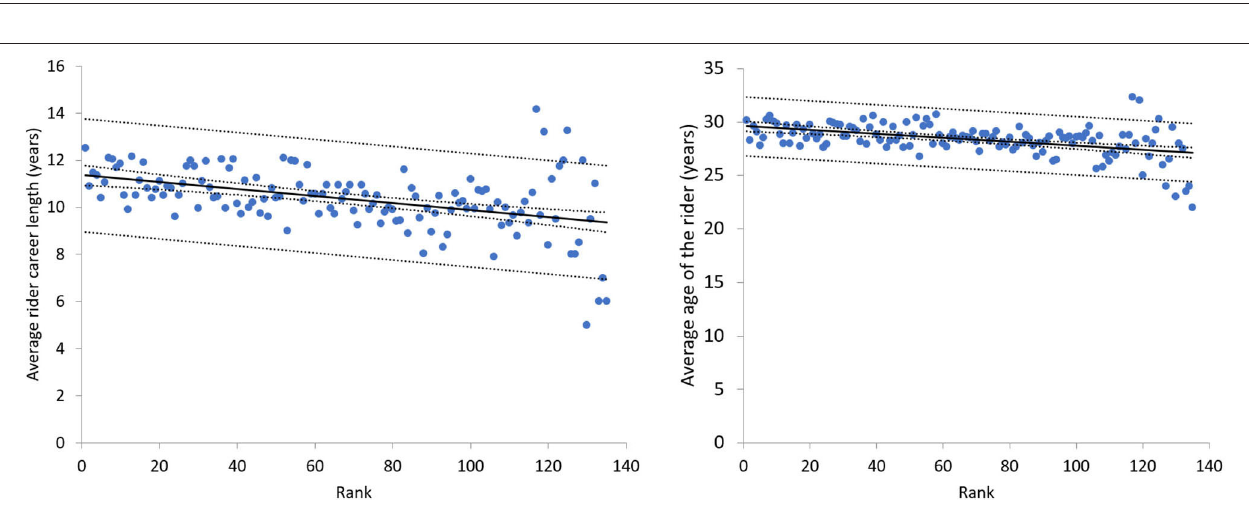
FIGURE 4 | Results from Alejandro Valverde and Philipe Gilbert over the years on Liège-Bastogne-Liège.